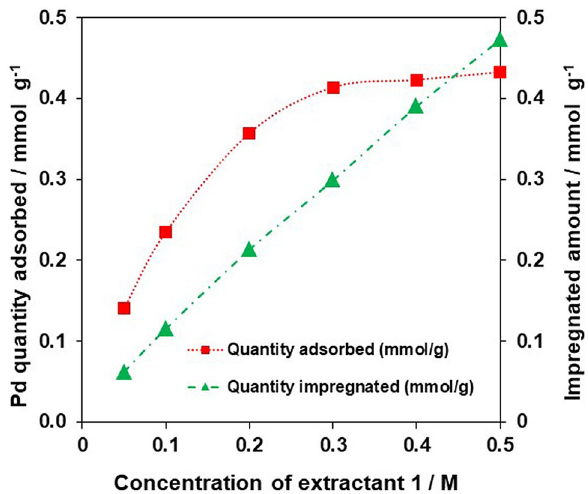
Figure 1. Relationship between amount of 1 impregnated in XAD-7 and the Pd(II) quantity adsorbed by 1 - EIR. Sorption conditions: 1 -EIR = 0.1 g; [Pd(II)] = 500 ppm (= mg L −1 ); [HCl] = 0.1 M; shaking speed = 280 rpm; shaking time = 24